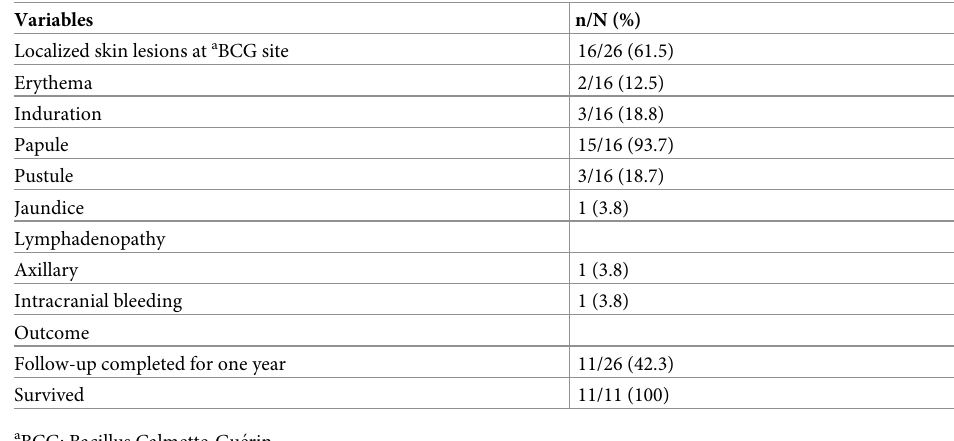
Table 2. Adverse reactions of BCG overdose in newborns at a tertiary care hospital, Karachi.